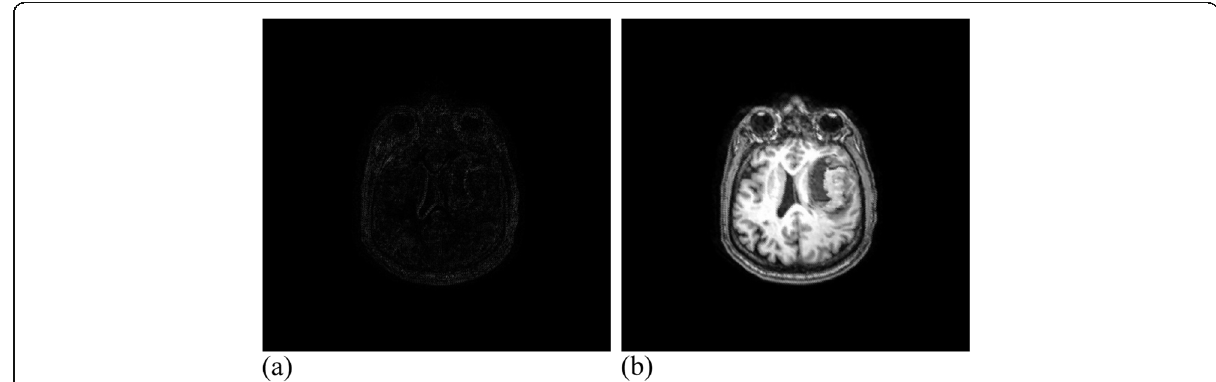
Fig. 10 MRI data after registration. ( a ): Difference between MRI reference image and registration image; ( b ): MRI registration